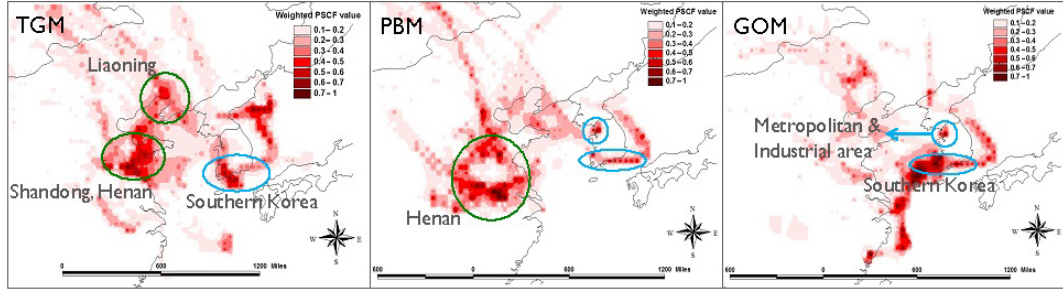
Figure 7. PSCF results for TGM (left), PBM (middle), and GOM (right) using the top 25% of concentrations as criteria. Table 4. Estimated contribution of Korean and out-of-Korean sources on variations of speciated Hg concentration. Cluster Cluster frequency (%) Average concentration ∗ Source contribution (%) Korean (%) Out-of-Korean (%) TGM GOM PBM TGM GOM PBM